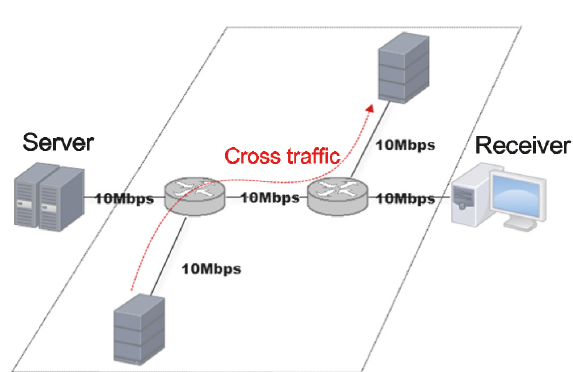
Figure 8: Monitoring tools for video packets at the client.